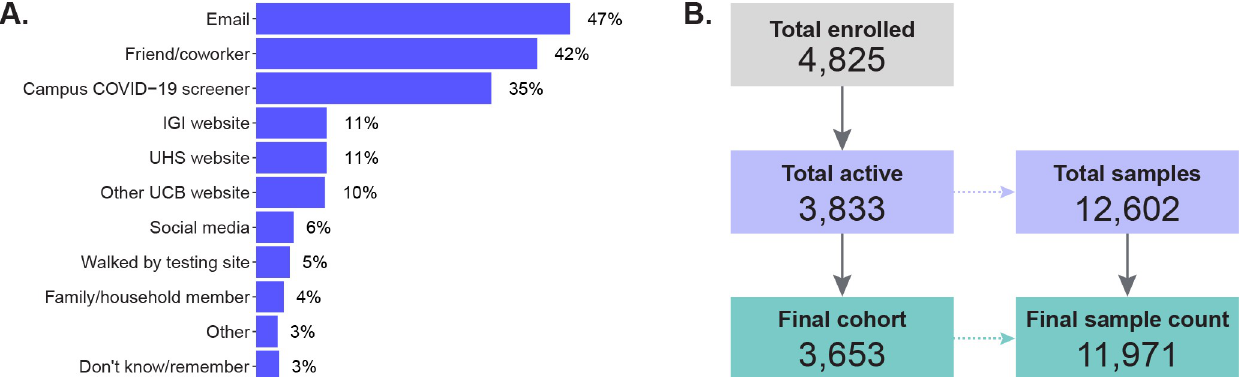
Fig 1. IGI FAST recruitment. (A) Results from an exit survey question asking respondents to report through which methods they heard about IGI FAST. Respondents (n = 865) could select multiple answers. Abbreviations: IGI, Innovative Genomics Institute; UHS, University Health Services; UCB, University of California, Berkeley. (B) Of the 4,825 participants who enrolled, 992 did not give any samples, leaving 3,833 participants who gave 12,602 samples. A supply-chain shortage in week 11 caused a large number of samples (94% of samples collected in week 11) to go untested. For this reason, all 631 samples collected at the beginning of week 11 are excluded from the analysis of IGI FAST. One hundred eighty individuals only provided a sample during week 11, so they are excluded from the analysis of IGI FAST, leaving a final cohort of 3,653 participants that gave 11,971 samples in the studied weeks of IGI FAST.